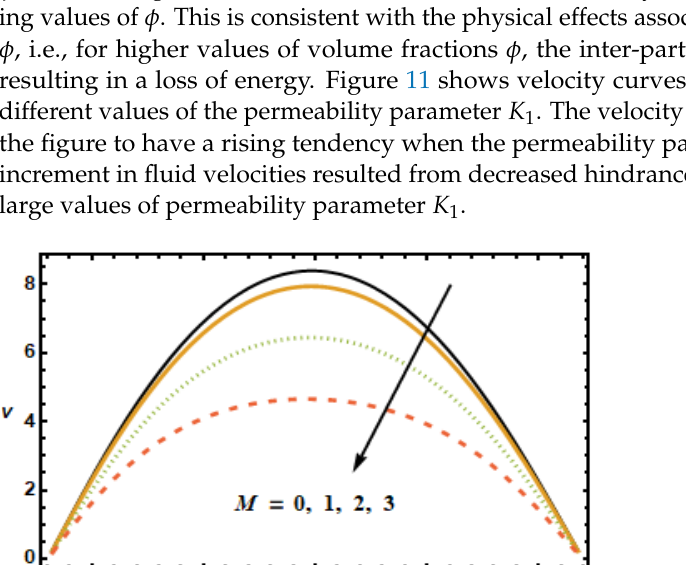
v on Hartman number